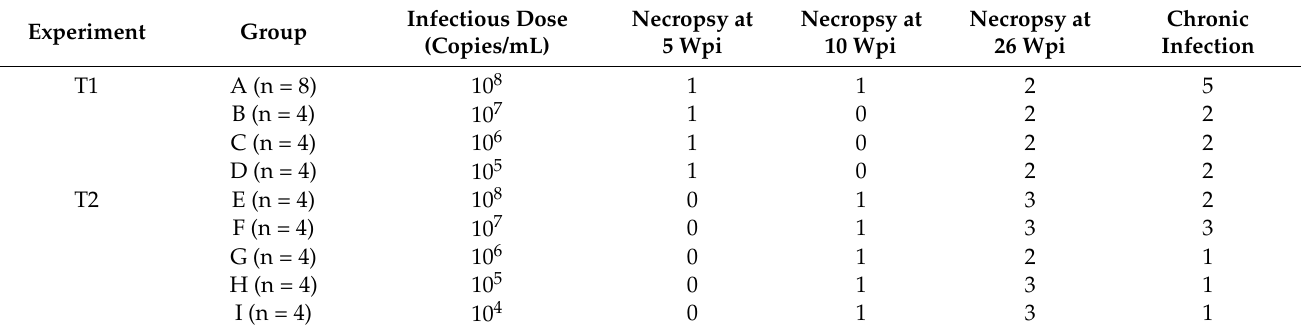
Table 1. Design of the experimental HEV infection in SPF